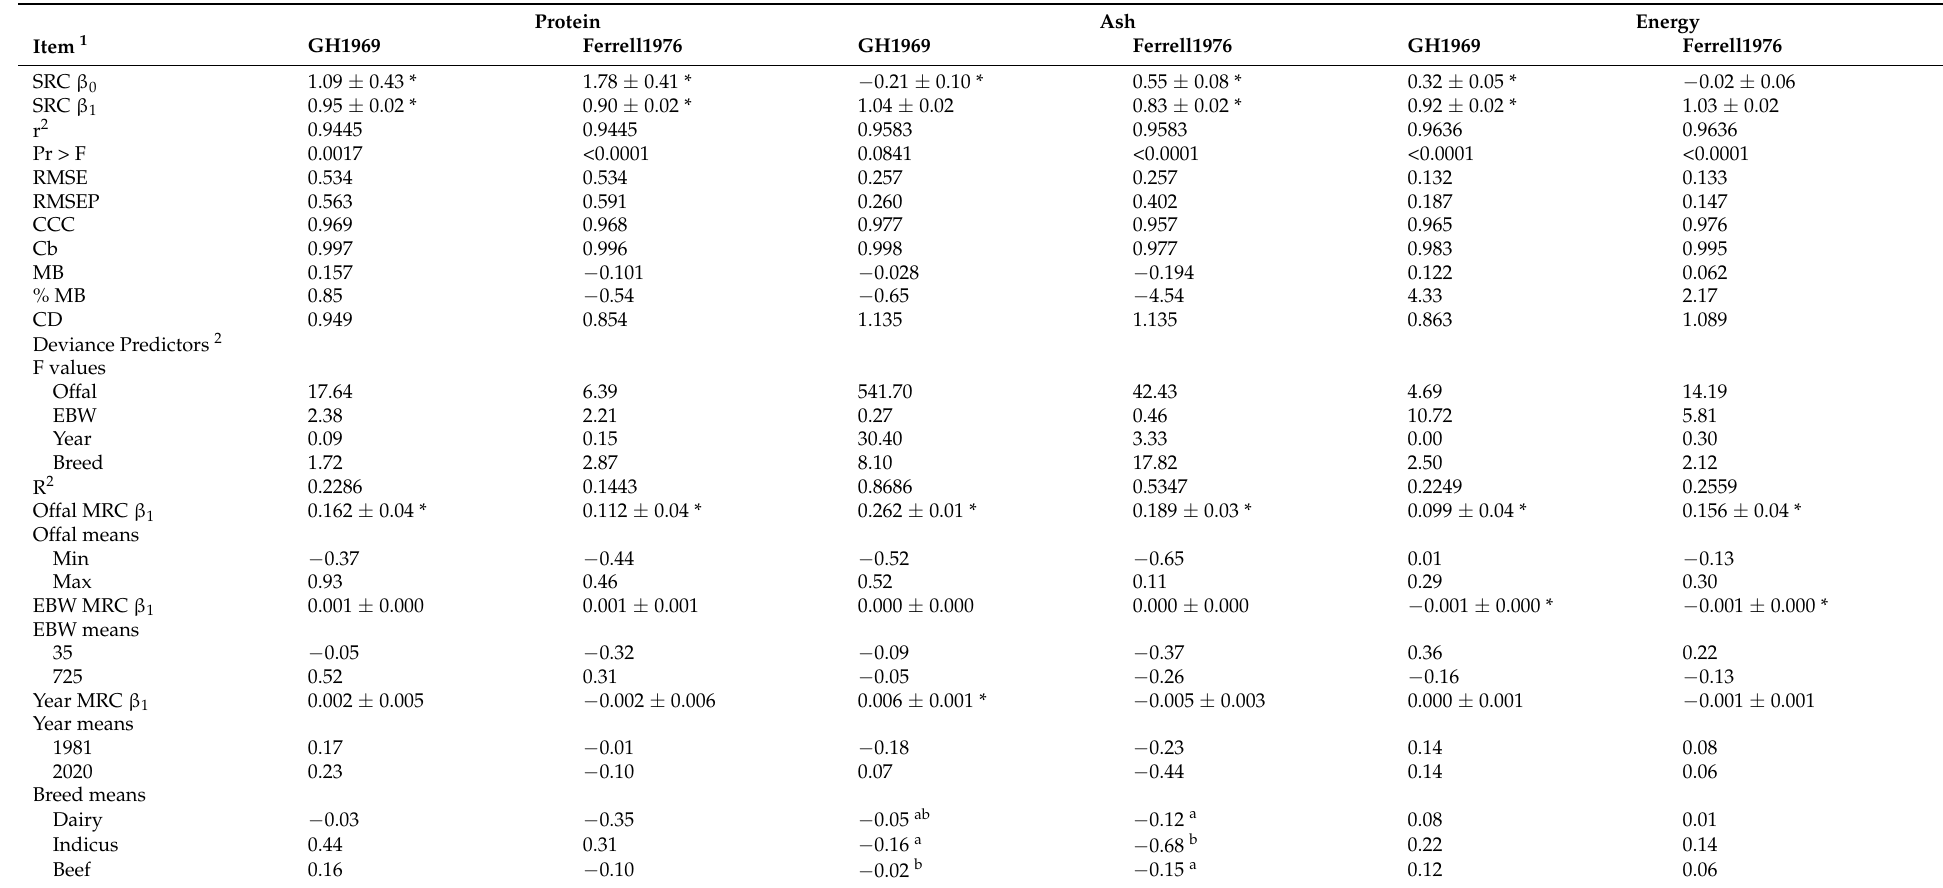
Table 14. Model evaluation of predicting empty body chemical protein, ash, and energy assuming carcass chemical composition is known, and predictive variables of the deviance between observed and predicted empty body chemical components in the Empty Body-Carcass